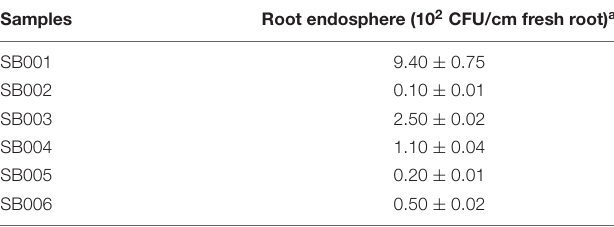
TABLE 1 | Total bacterial population at harvest.